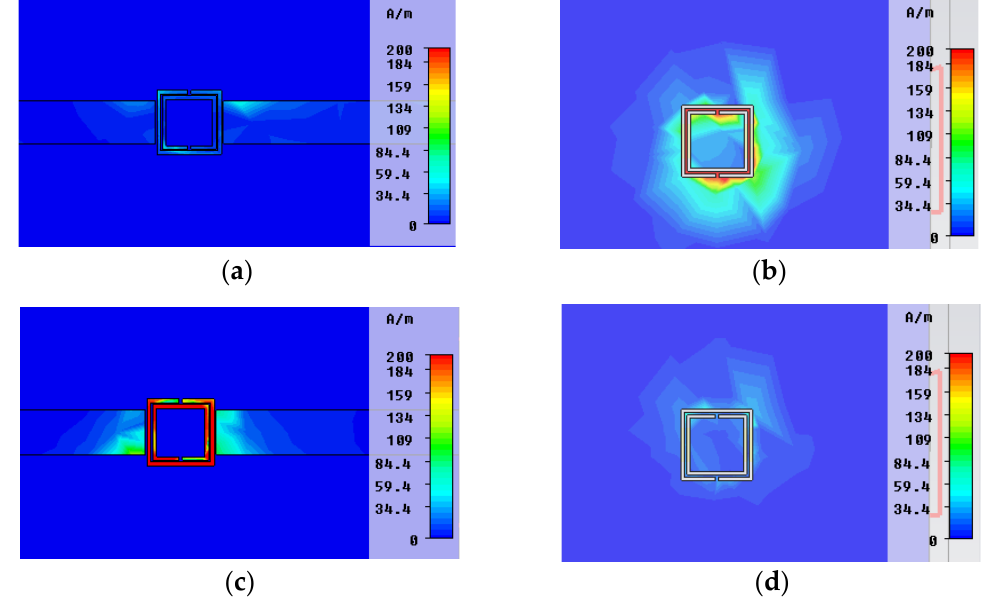
Figure 6. Surface current distribution. ( a ) Surface current in upper metallization layer at f 0 = 4.24 GHz. ( b ) Surface current in bottom metallization layer at f 0 = 4.24 GHz. ( c ) Surface current in upper metallization layer at f 1 = 5.51 GHz. ( d ) Surface current in bottom metallization layer at f 1 = 5.51 GHz.